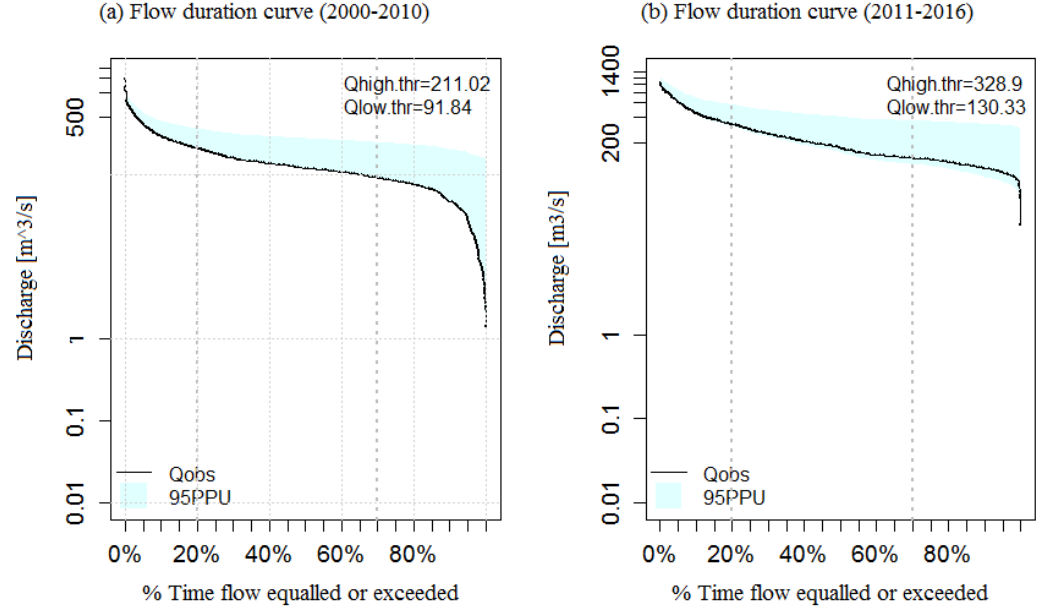
Figure 6. Flow Duration Curve of Tana River, comparing period 2000–2010 and period 2011–2016 showing observed streamflows (Qobs) for two uncertainty bounds (95PPU being upper bound at 95% confidence level).